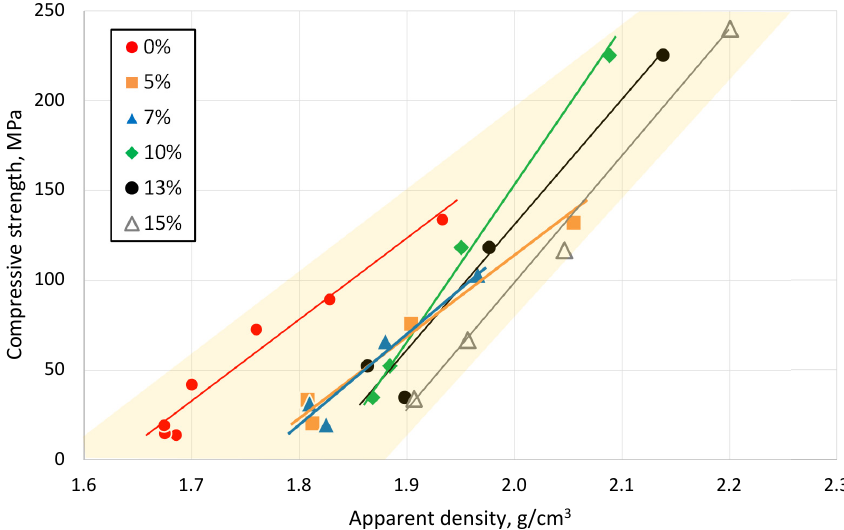
Figure 12. Dependence of compressive strength on apparent density of tested clay-glass ceramic materials after sintering at temperatures from 700 up to 1000 °C.